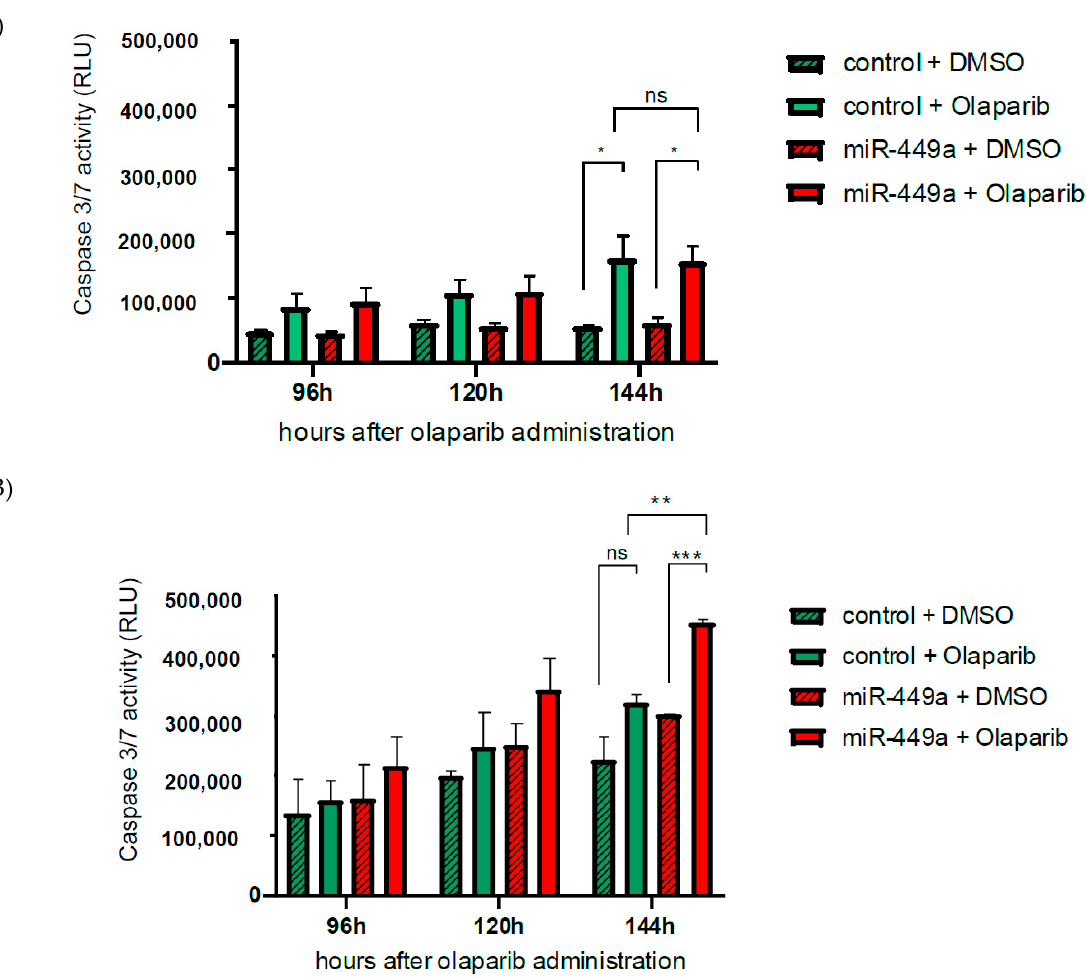
Figure 5. Induced expression of miR-449a in combination with Olaparib strongly decreased the amount of viable HCC1937 cells with a pathogenic variant in BRCA1. HCC38 ( A ) and HCC1937 ( B ) cells were treated with Olaparib (DMSO as control) and transfected with miR-449a (or control). Apoptosis analyzed by caspase3/7 activity in TNBC cells transfected with miR-449-mimics normal- ized to cell viability. Bar graphs show mean ± SD * p < 0.05, ** p < 0.01, *** p < 0.001, ns: not significant; 2-way Anova with Tukey’s multiple comparisons.